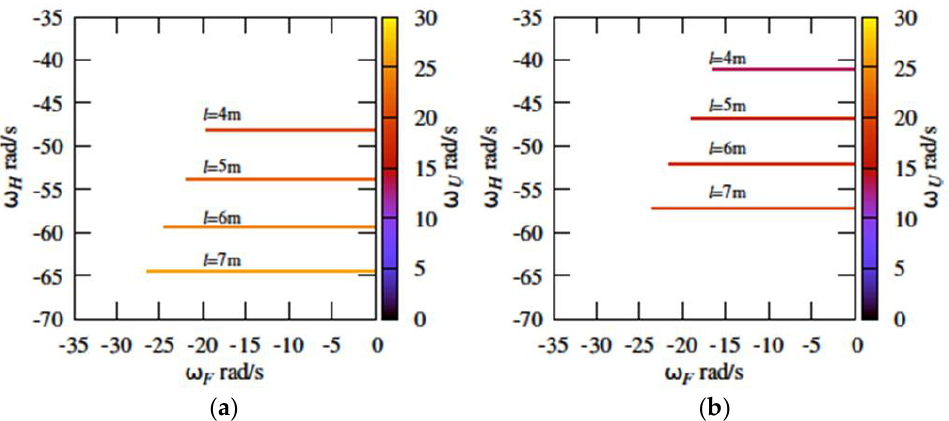
Figure 5. Hand and forearm angular velocities as a function of the upper arm angular velocity for the different horizontal shot distances of ( a ) h = 0.15 m and ( b ) h = 0.30